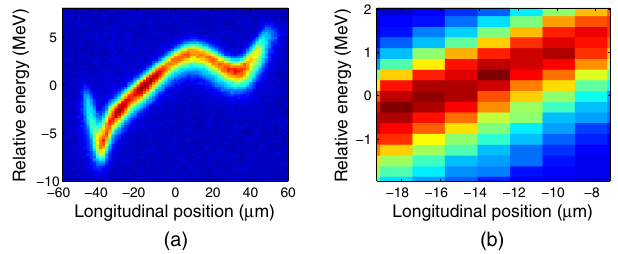
FIG. 15. (a) Image of a 0.5 kA beam, 30 keV induced energy spread from the heater, taken with the XTCAV voltage at 8 MV. (b) Zoom of the same image shows the variation in the central energy of neighboring pixels (0.25 MeV) is smaller than the measured SES (0.91